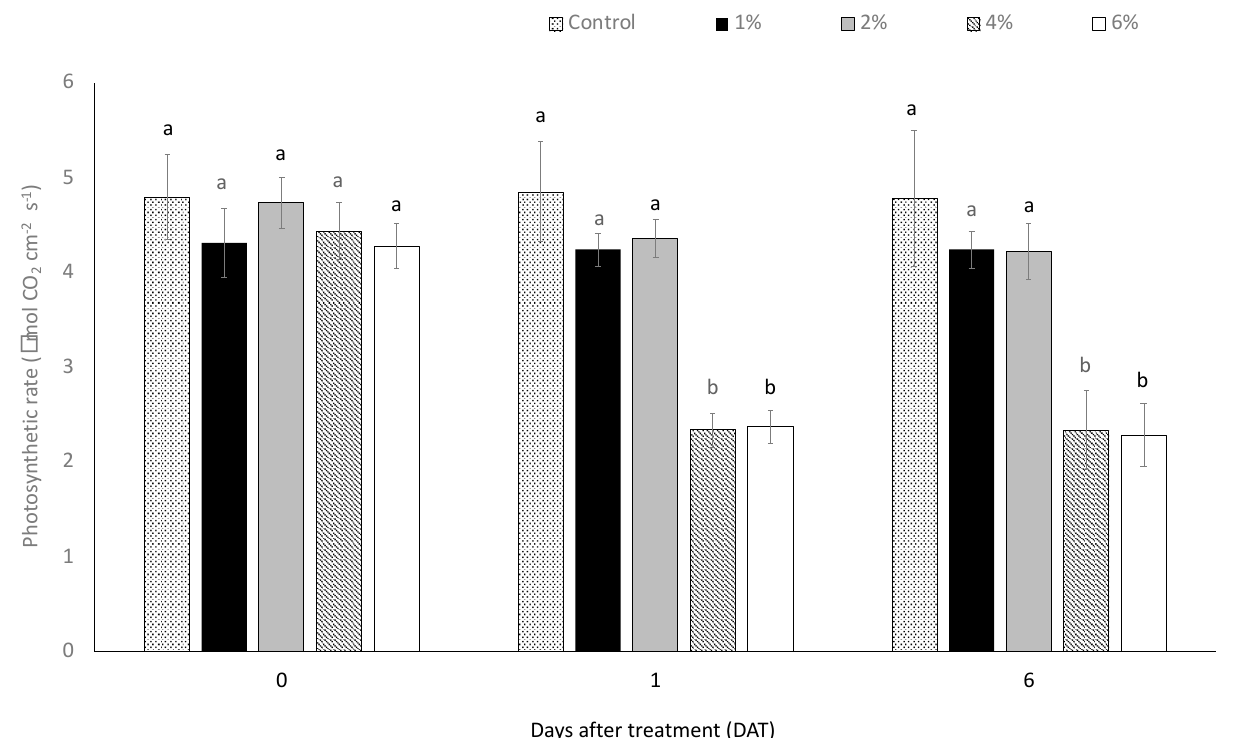
Figure 3. Photosynthetic rate ( µ mol CO 2 cm − 2 s − 1 ) ± SE registered in the plants at 0, 1, and 6 days after treatments with different concentrations of Citrus sinensis EO nano-emulsion. Different letters indicate statistical differences among the different treatments at the same exposure time (ANOVA, p < 0.05).